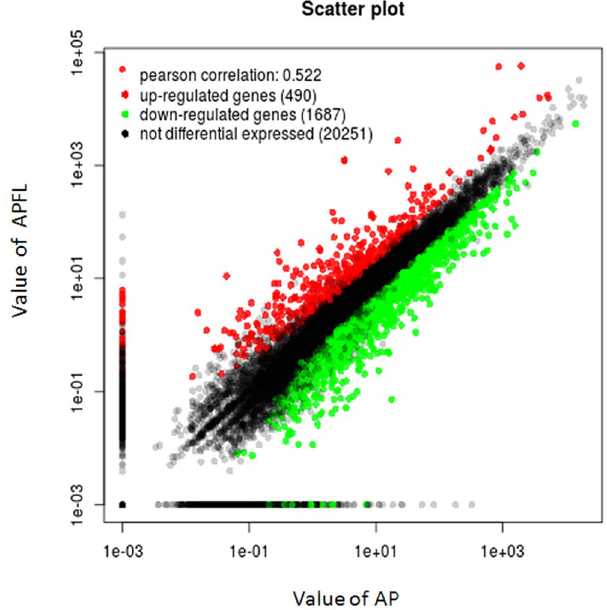
Figure 3. Differentially expressed genes between APFL and AP. Red spots represented up-regulated genes, and green spots down-regulated genes. Black spots indicate genes that were not differentially expressed between the two